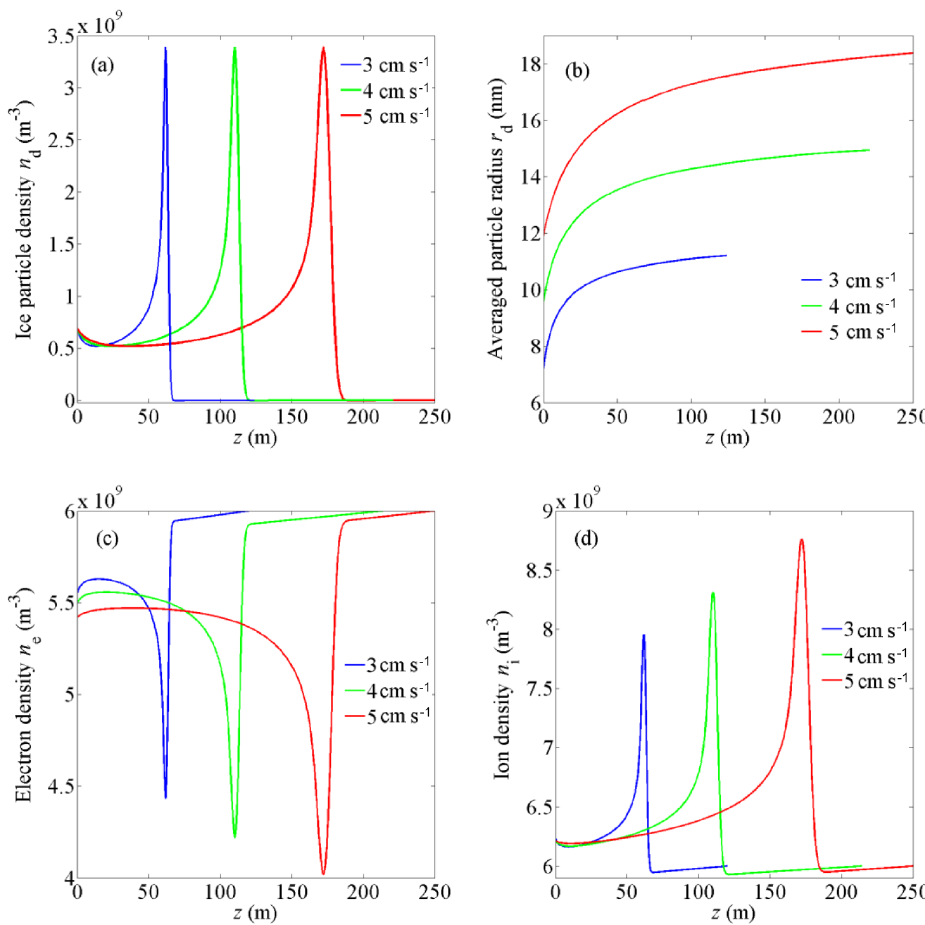
Figure 7. The distribution of (a) ice particle density, (b) the averaged particle radius, (c) electron density, and (d) ion density for various vertical wind speeds near the lower boundary of the condensation